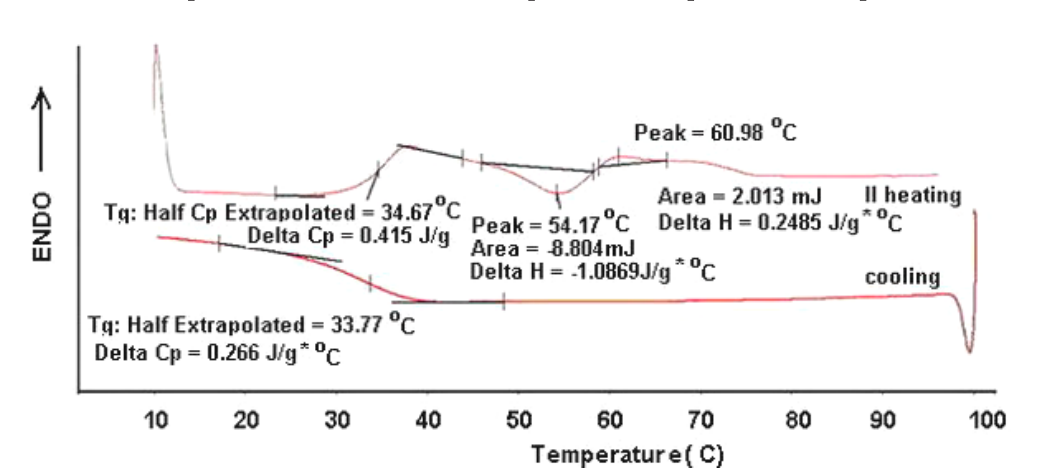
Fig. 7 Second DSC heating/cooling cycle, corresponding to the Sample 3 (10 K/min)